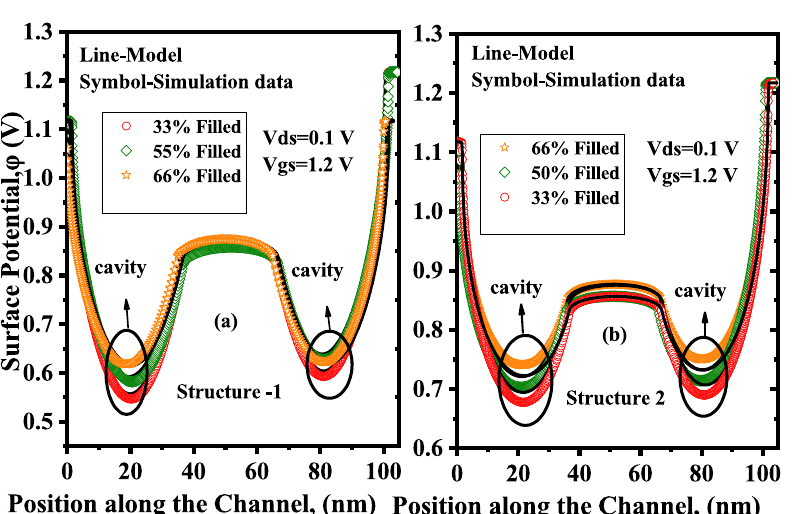
Figure 13. Surface potential of the partially filled cavity (66%,50%,33% filled) ( V gs = 0 V , V ds = 0.1 V , κ = 12 , N f = 0